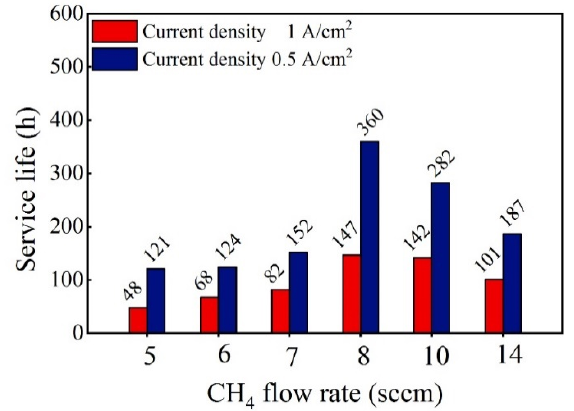
Figure 3. The e ff ect of the CH 4 flow rate during the nucleation stage on the accelerated life tests (ALT) life of Ti / BDD electrodes.